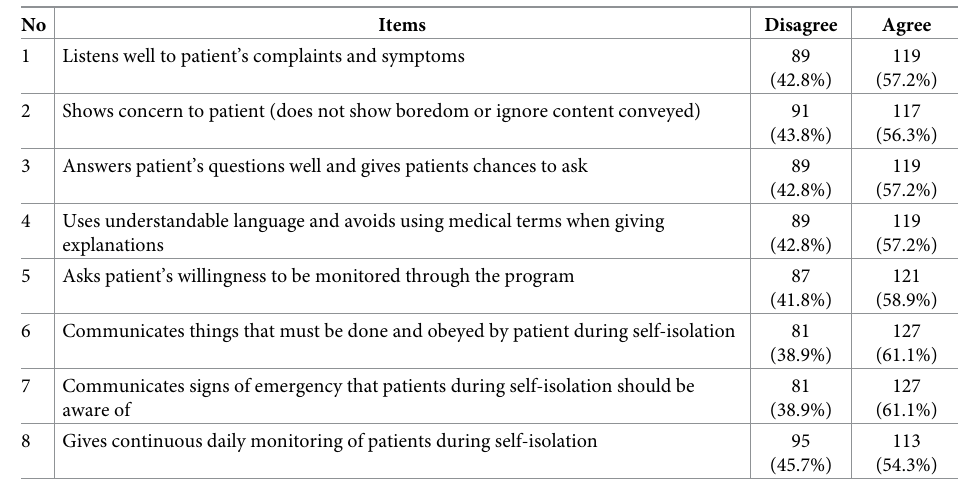
students (49%) did not. After the completion of the module, 144 students (69.2%) were inter- ested in COVID-19 volunteering, and 64 (30.8%) were not. A significant difference existed in the proportion of students interested in COVID-19 volunteering before and after the module completion (51% vs. 69.2%, respectively, p < 0.001).